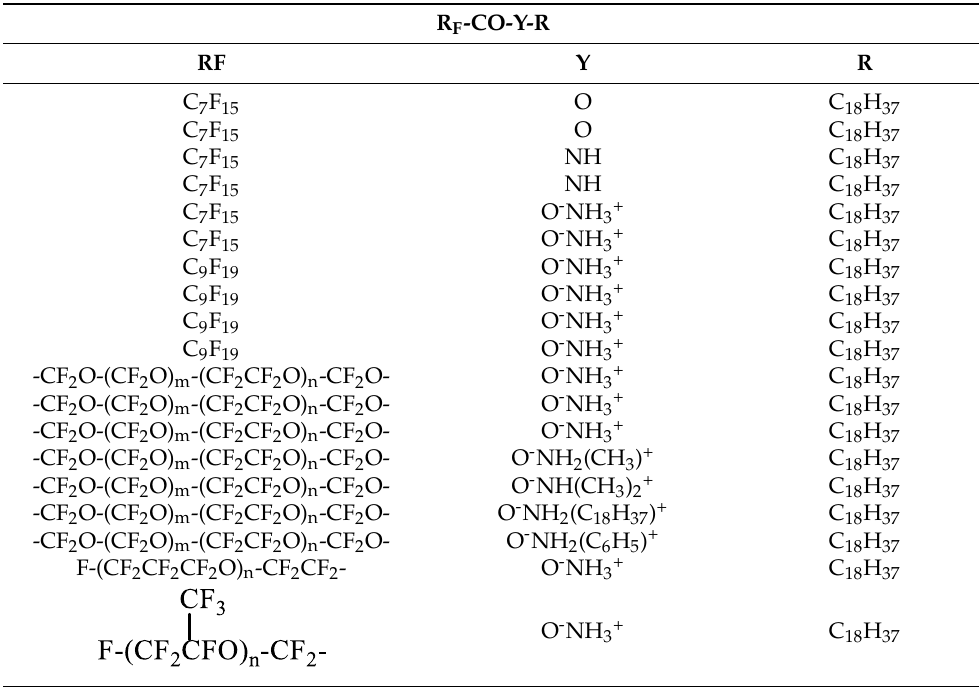
Table 7. Composition of perfluoropolyethers (PFPEs) lubricants.